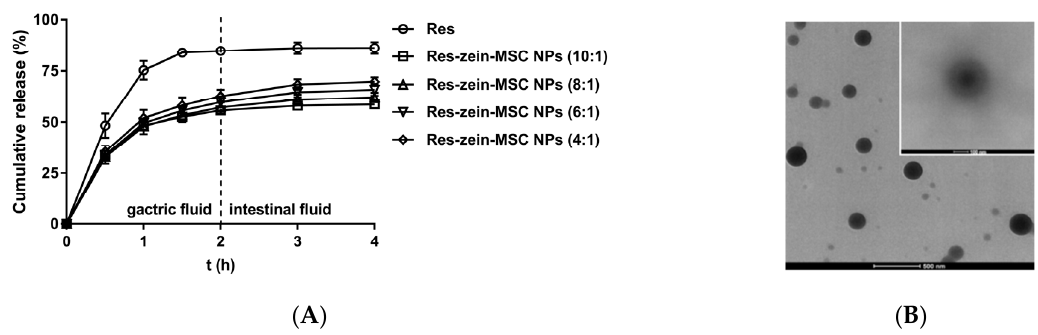
Figure 3. The release profiles of Res and Res-zein-MSC NPs ( A ); TEM images of Res-zein-MSC NPs before and after (upper right corner) pepsin digestion ( B ).